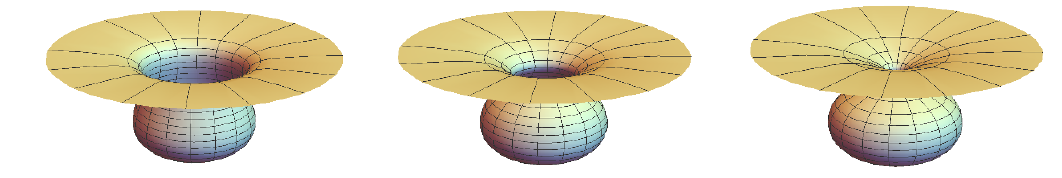
Figure 2 . The schematic diagrams for an evaporating black hole that ends up with a Planckian neck and a large internal space, from left to right in time sequence. Note that the notion of distance is distorted in the diagrams because this geometry does not admit an embedding in 3D (cid:13)at space.